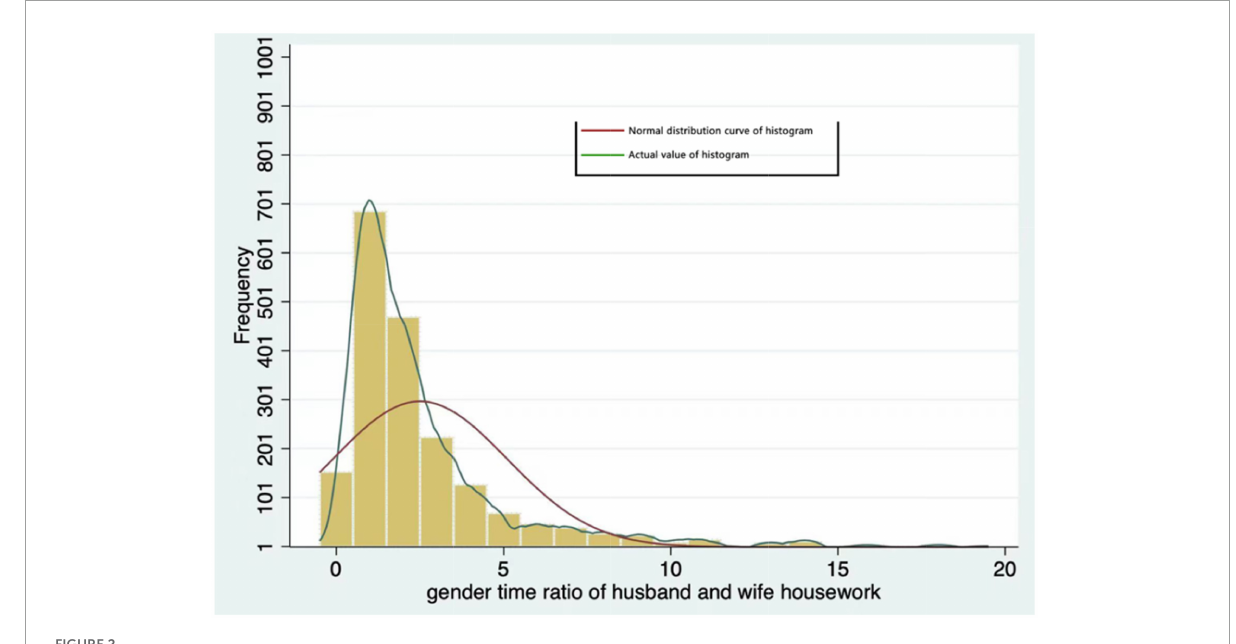
FIGURE2 Distribution histogram of gender difference in housework